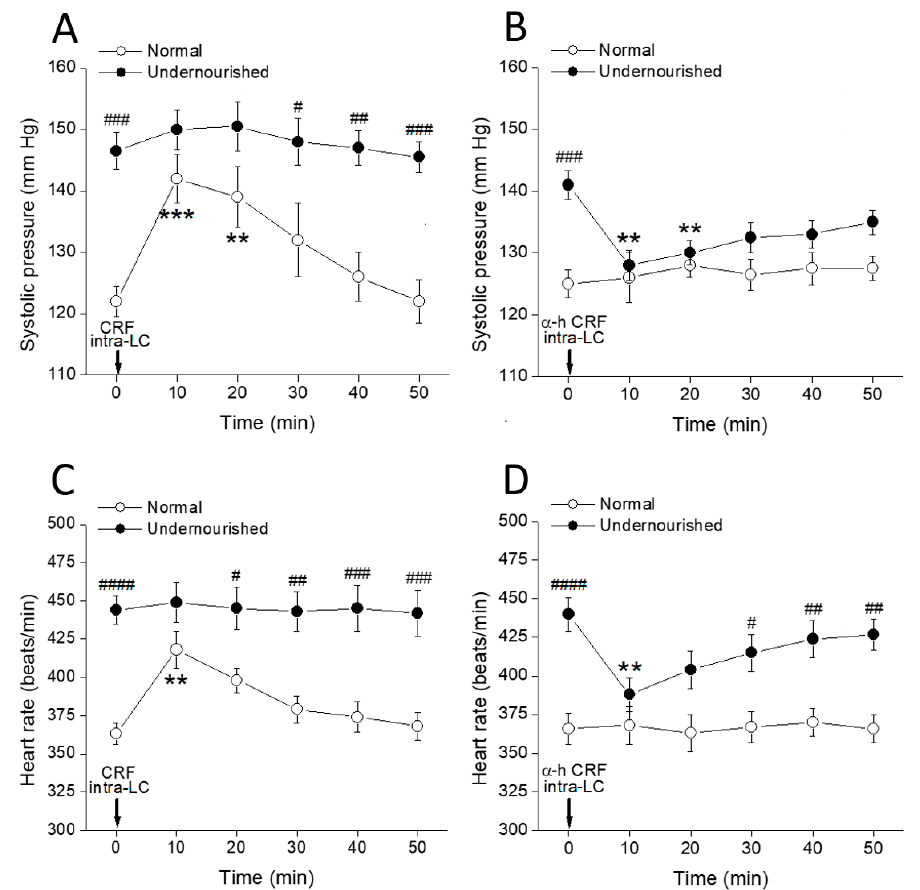
Figure 3. Time-course of changes in systolic pressure ( A , B ) and heart rate ( C , D ) of normal and prenatally undernourished rats after intra-LC microinjection (arrow at time 0 min) of CRF (20 pmol/side; ( A , C )) or the CRF receptor antagonist α -helical CRF ( α -h CRF, 26 pmol/side; ( B , D )). Values are means ± SEM, n = six rats in each group. Two-way repeated measures ANOVA was used to identify the nutritional treatment and/or the time elapsed after drug microinjection as significant factors in the effect examined (( A ): for the effect of phenylephrine on systolic pressure, F nutrition(1, 10) = 30.58 and F time(5, 50) = 4.772; ( B ): for the effect of prazosin on systolic pressure, F nutrition(1, 10) = 17.40 and F time(5, 50) = 1.441; ( C ): for the effect of phenylephrine on heart rate, F nutrition(1, 10) = 61.82 and F time(5, 50) = 2.161; ( D ): for the effect of prazosin on heart rate, F nutrition(1, 10) = 46.11 and F time(5, 50) = 1.684). Significance symbols arising from the post hoc tests indicate either intragroup differences after CRF or α -helical CRF referred to the pre-drug control at time = 0 min (** p < 0.01, *** p < 0.001, Dunnett’s multiple comparisons test) or intergroup differences between normal and undernourished subjects ( # p < 0.05, ## p < 0.01, ### p < 0.001, #### p < 0.0001, Bonferroni’s multiple comparisons test).